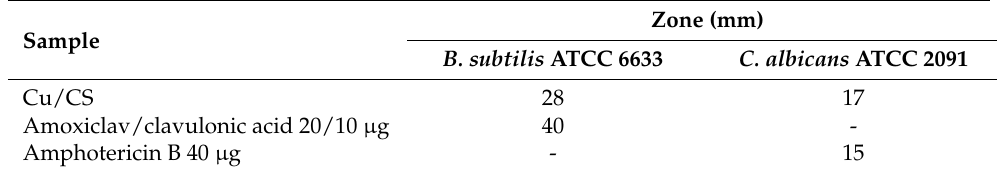
Table 1. Antimicrobial activity of Cu/CS composites (Low molecular weight chitosan, molar ratio Cu/CS =